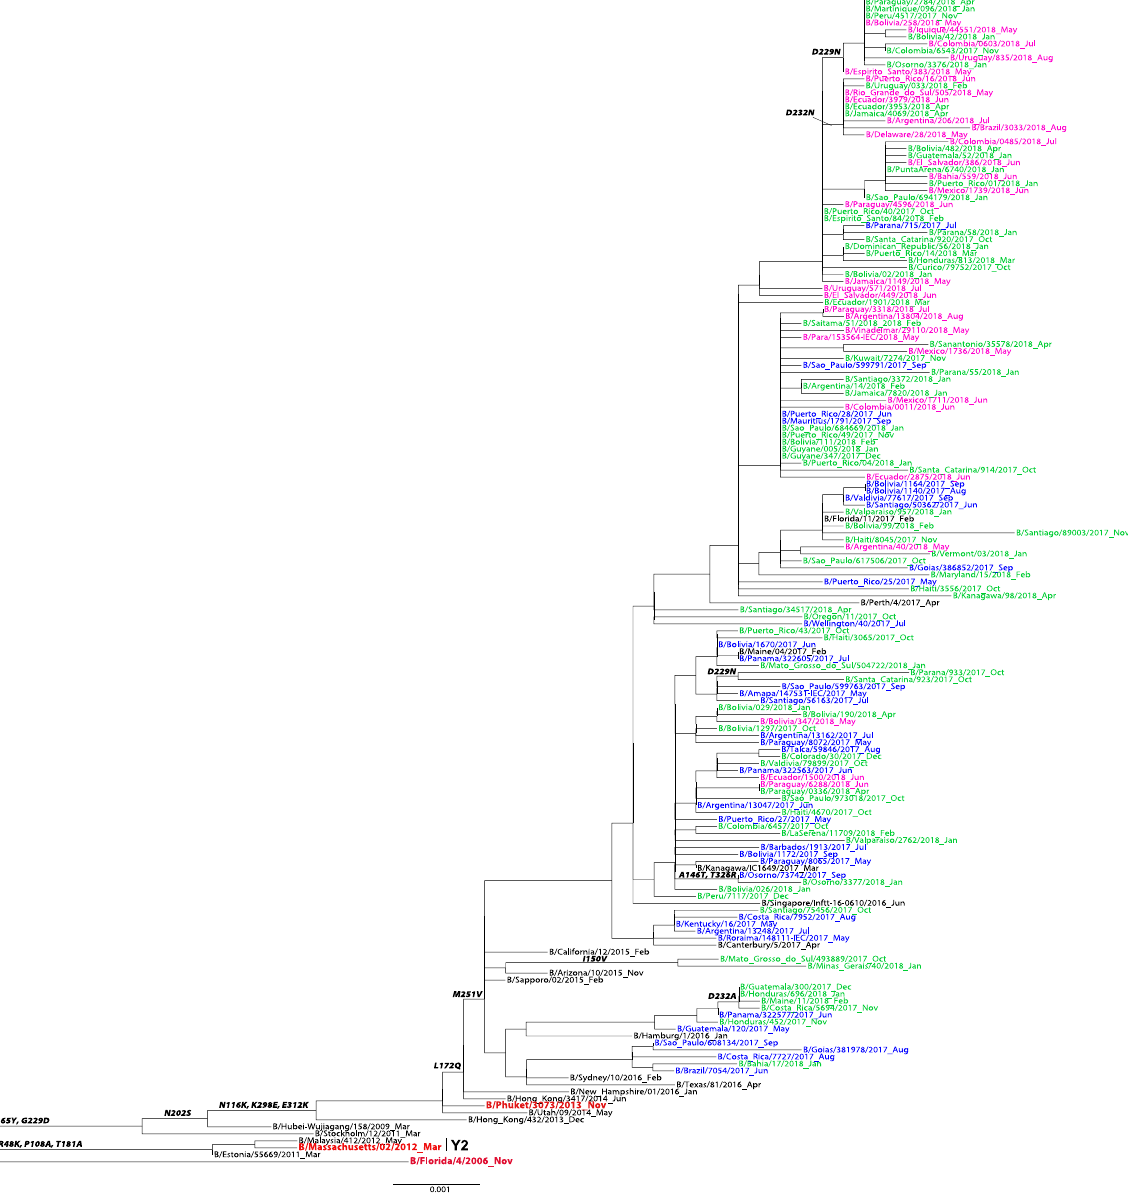
Fig 4. Representative maximum-likelihood tree n = 141 influenza B virus Yamagata HA gene sequences from in Mexico, South and Central America; sequences from the current and previous vaccine strains (in red) and reference viruses detected worldwide indicated by the CDC WHO CC. HA sequences of influenza viruses collected from May to September 2017 are in blue, October 2017 to April 2018 are in green, May to September 2018 are in pink. Sequences from the time period before the period of analysis, are in black. Amino acid changes and addition (ADD GLY) and loss (LOSS GLY) of glycosylation sites are indicated in bold in the